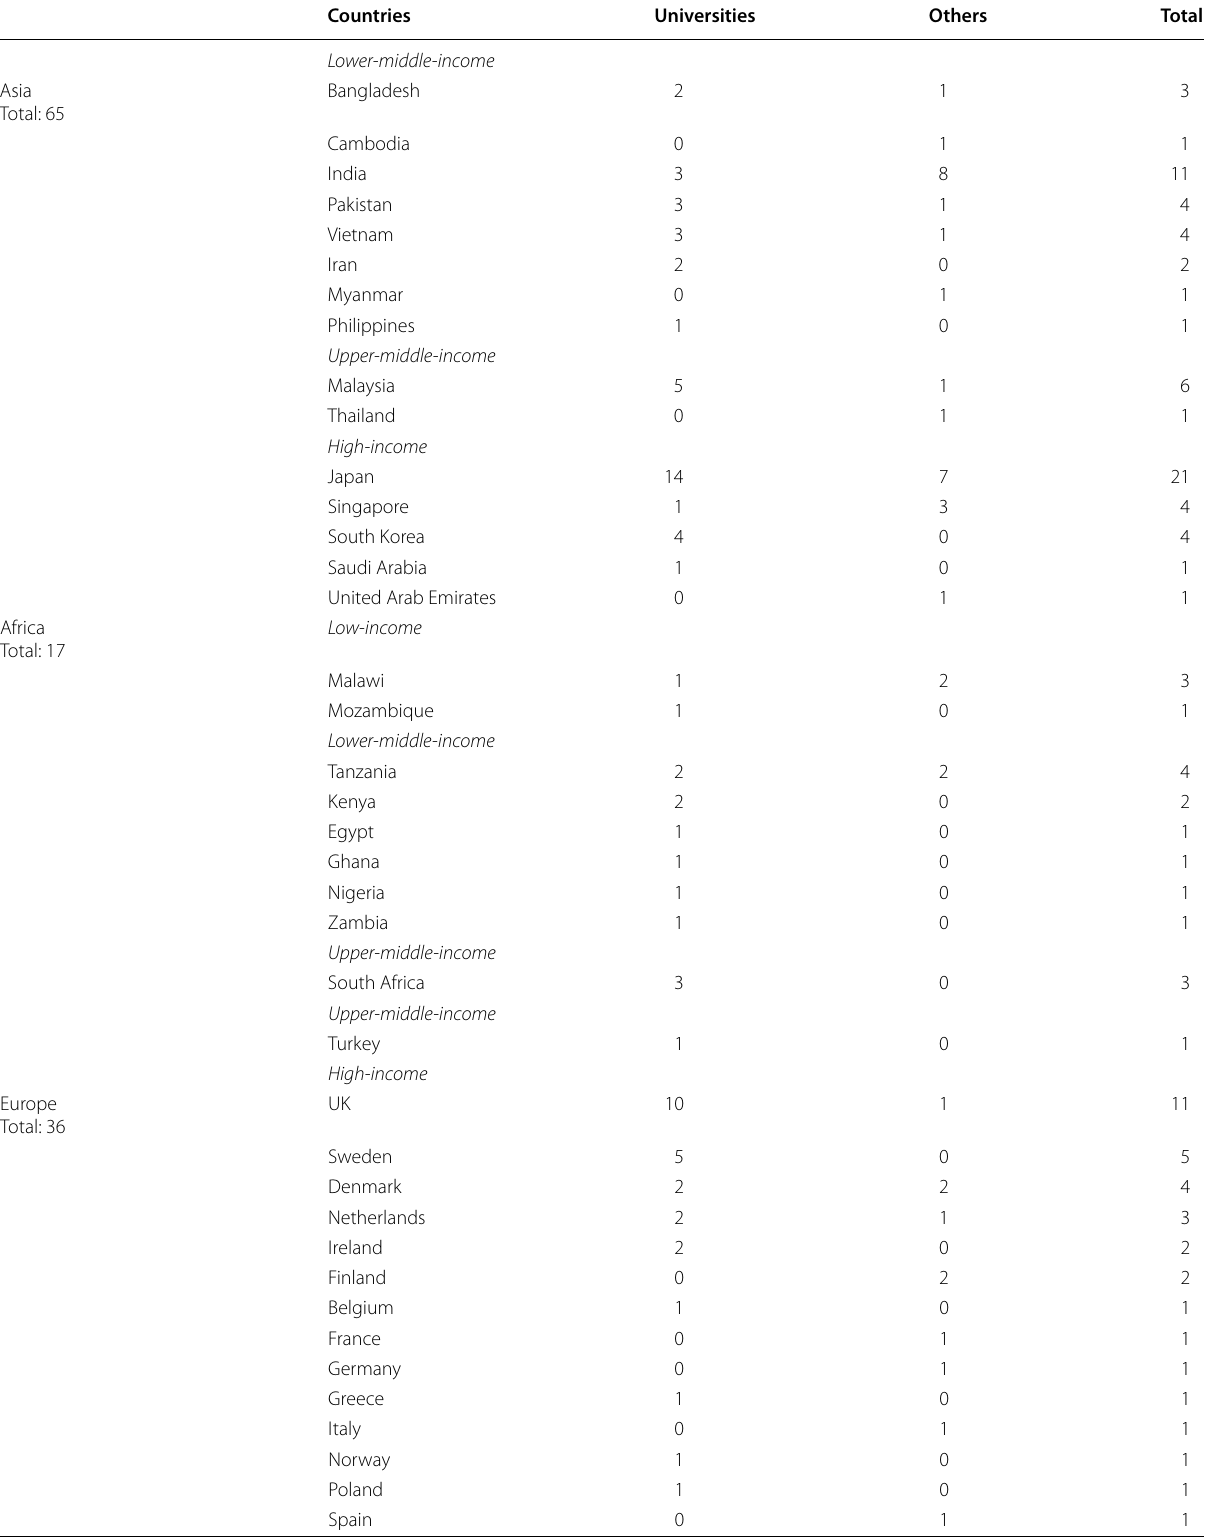
Table 2 Number of overseas collaboration institutions by country Countries Universities Others Asia Total: